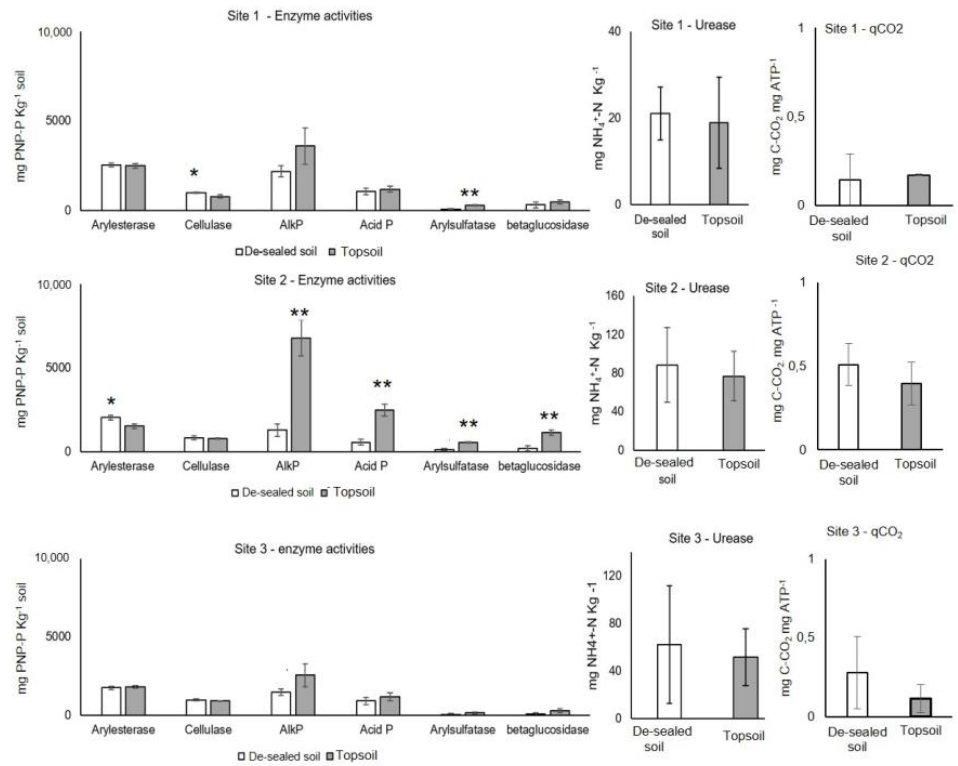
Figure 5. Enzyme activities, microbial biomass, respiration and metabolic quotient of de-sealed and